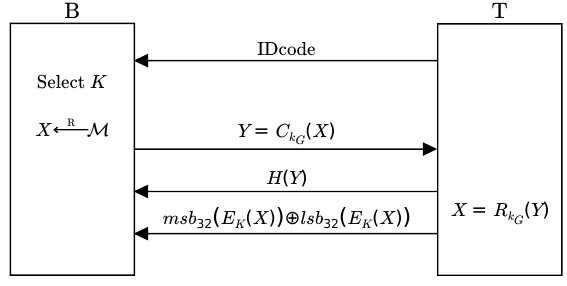
Figure 5: The TK5561 authentication